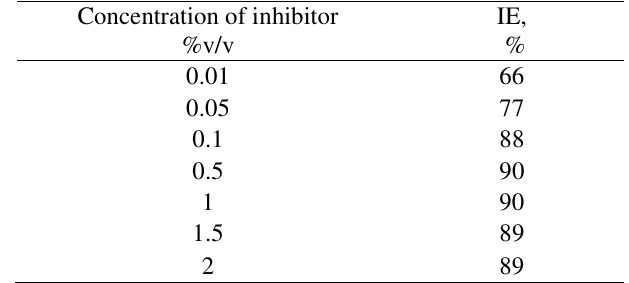
Effect of Nyctanthes arbortristis on corrosion of mild steel in H method).